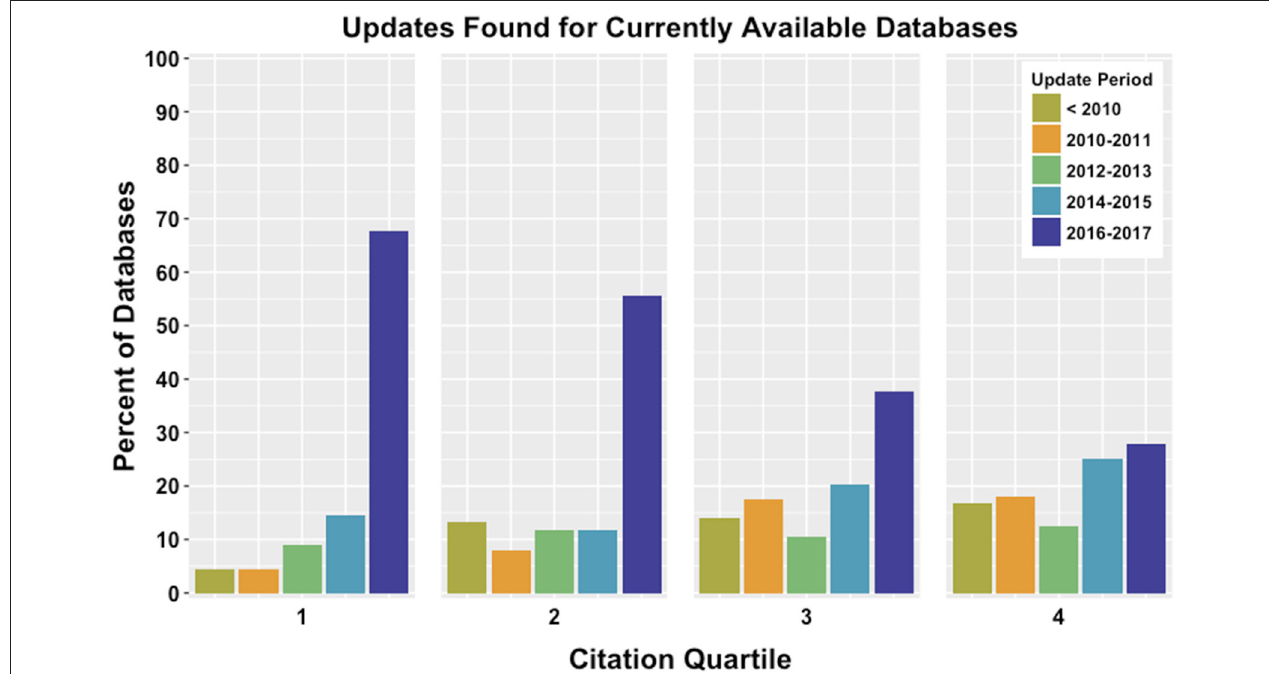
FIGURE 5 | Database websites for currently available databases were checked for evidence of updating. Using the sample of databases binned into Citation Quartiles, databases with updates found were assigned to categories of 2-year increments. Updating is correlated to citation quartile, and the largest portion of databases examined were updated within the 2015–2017 time